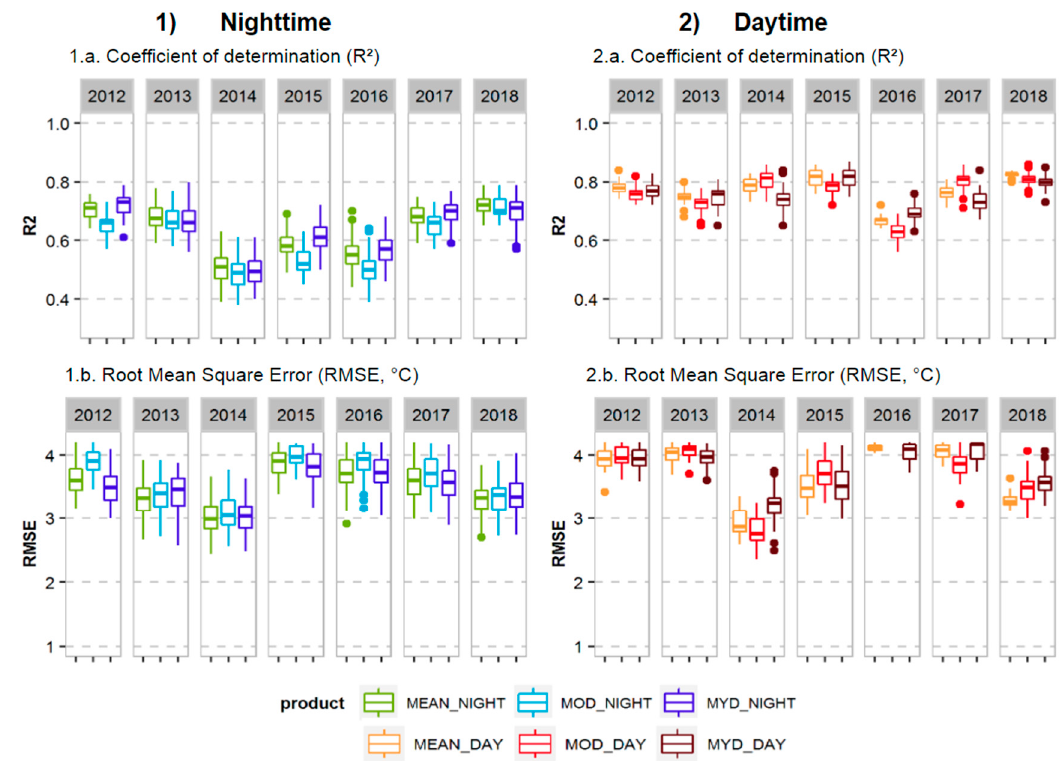
Figure 5. Boxplots of statistical indicators of the linear relationship between daily air temperature and daily land surface temperature derived from an 8 ‐ day composite (M*D11A2) from 2012–2018 gridded at different spatial resolutions, by the type of MODIS product for each year studied: ( a ) coefficient of determination (R 2 ) and ( b ) root mean square error (RMSE).